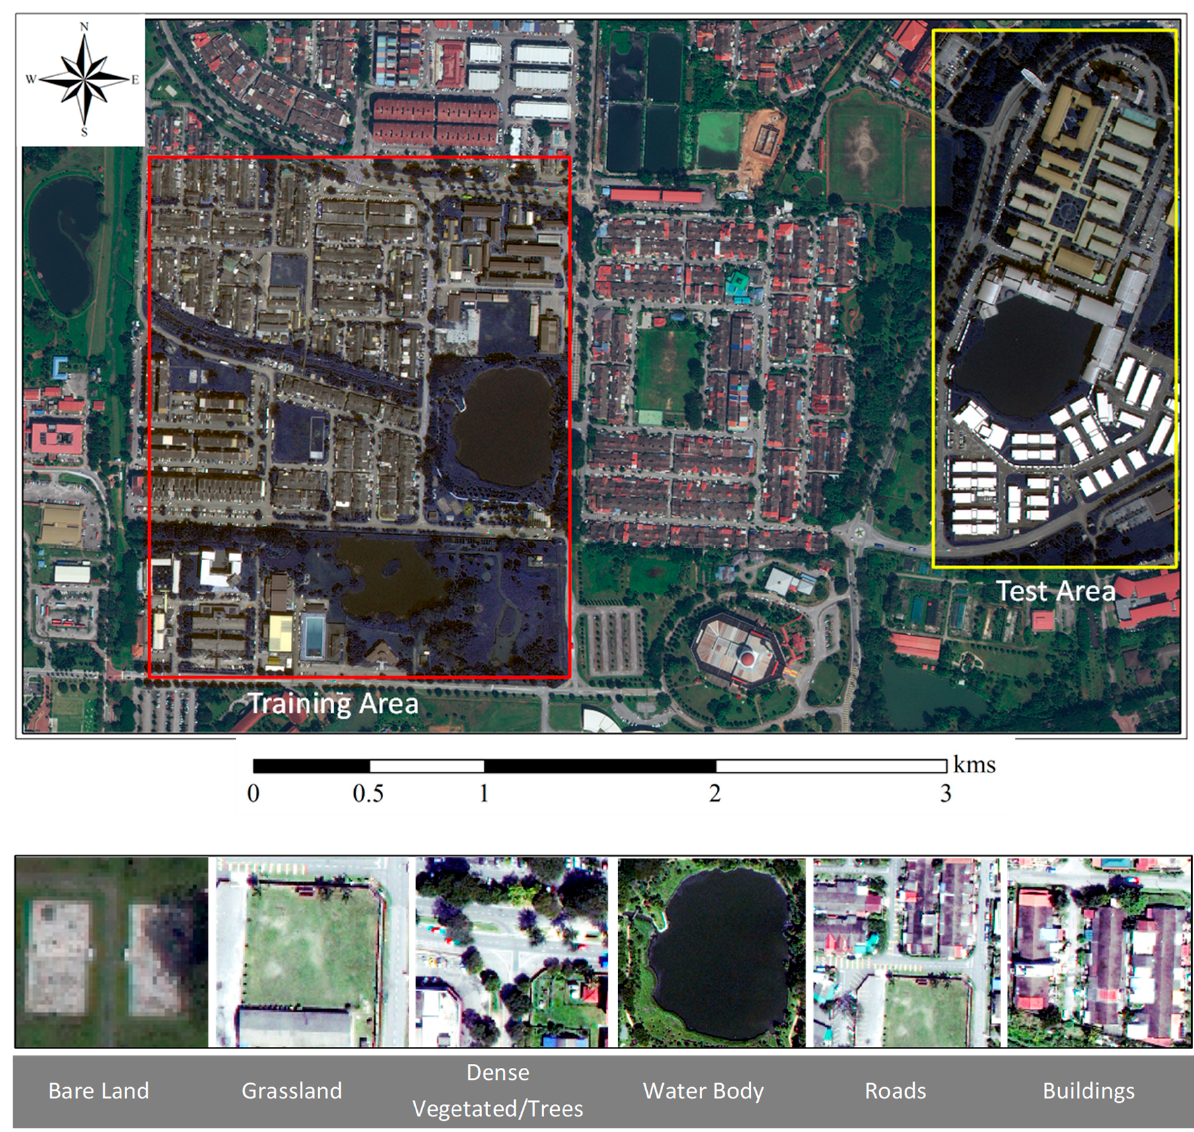
Figure 1. The training and test areas are indicated in the Worldview-3 true color composite of the study area.